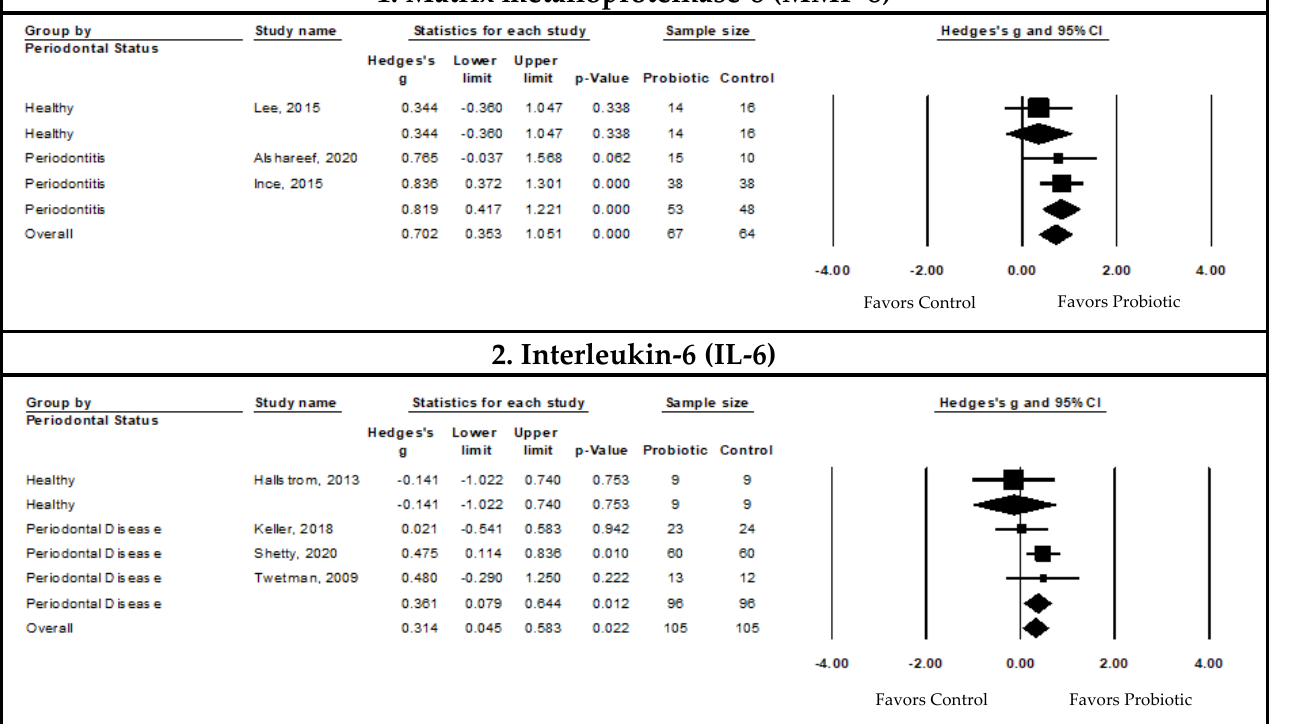
Figure 5. Pooled meta-analysis examining the effects of probiotic supplementation on immunological outcomes in periodontal disease patients; 1. Forest plot of the Hedge’s g SMD comparing the effects of probiotic supplementation to control groups on the gingival crevicular fluid (GCF) level of matrix metalloproteinase-8 (MMP-8) using a random-effects model [59,67,78]. 2. Forest plot of the Hedge’s g SMD comparing the effects of probiotic supplementation to control groups on the GCF level of interleukin-6 (IL-6) using a random-effects model. Table 2. Subgroup analysis examining the effects of probiotic supplementation on clinical outcomes.